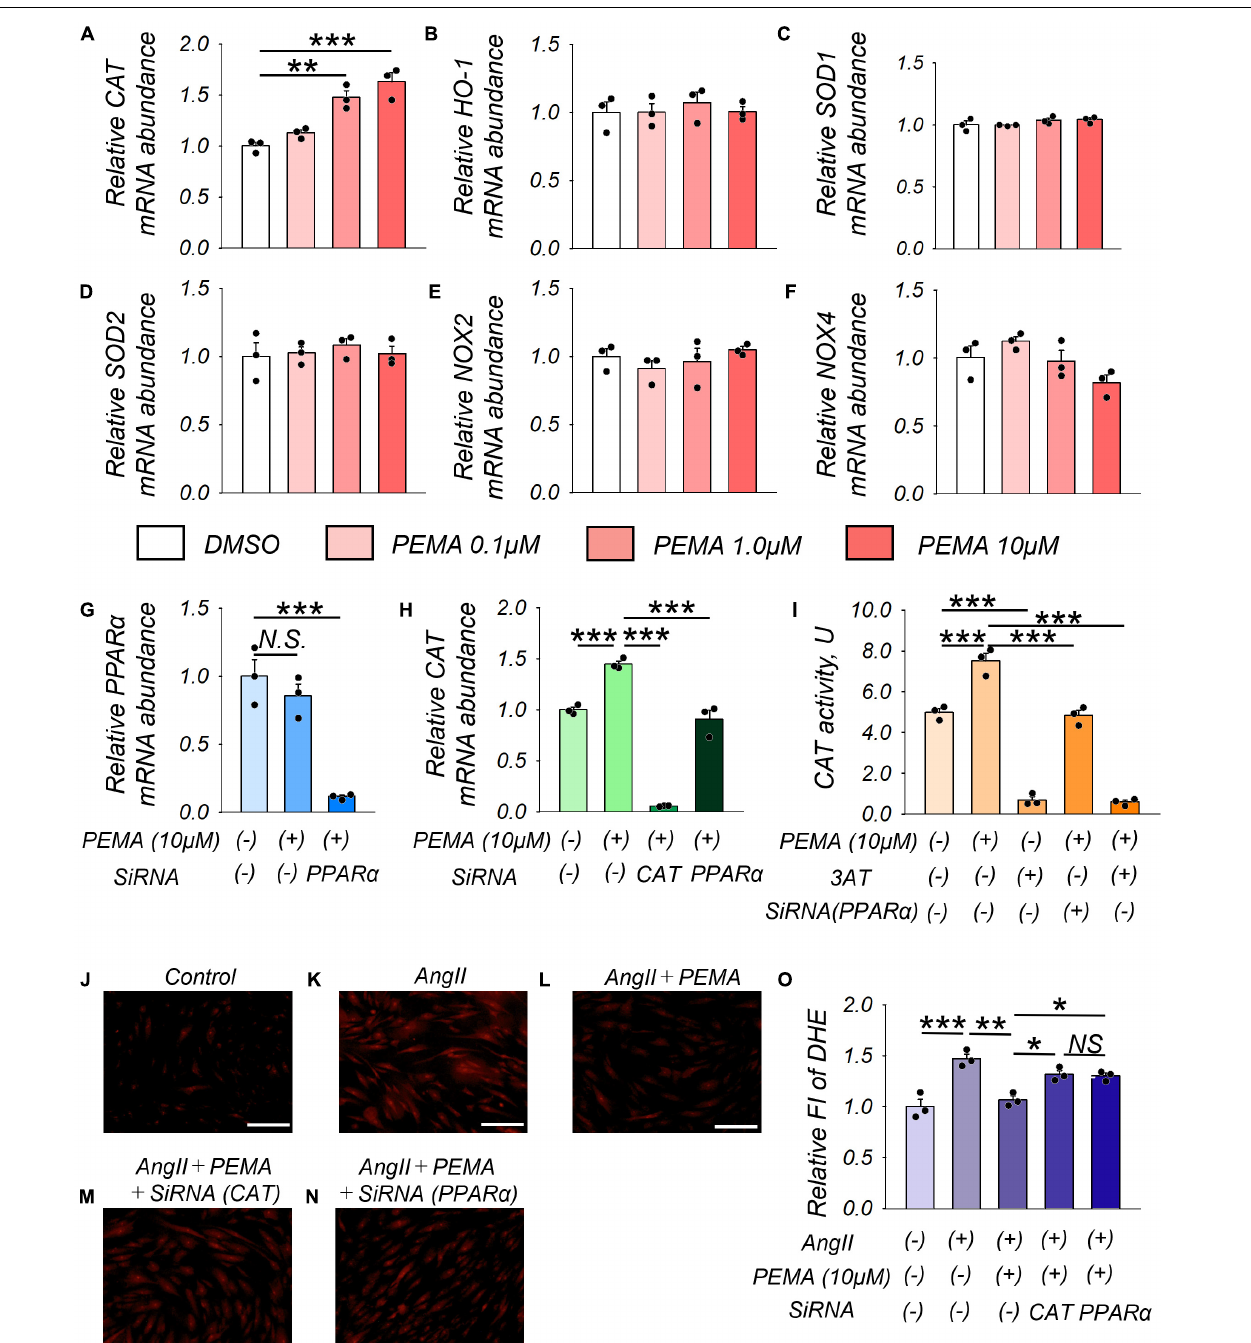
FIGURE 6 | Pemafibrate (PEMA)-mediated gene expression changes and the reduction in ROS in vascular smooth muscle cells (VSMCs). (A–F) mRNA expression levels of catalase ( CAT ), heme oxygenase-1 ( HO-1 ), superoxide dismutase 1 ( SOD-1 ), SOD-2 , nicotinamide adenine dinucleotide phosphate oxidases ( NOX2 and NOX4 ) in VSMCs treated with dimethyl sulfoxide (DMSO) and PEMA (0.1, 1.0, and 10 µ M) for 24 h. (G) mRNA expression levels of peroxisome proliferator-activated receptor alpha ( PPAR α ) in VSMCs treated with 10 µ M PEMA with or without transfection using SiRNA of PPAR α for 24 h before the PEMA administration. (H) mRNA expression levels of PPAR α in VSMCs treated with 10 µ M PEMA with or without transfection using SiRNA of CAT or PPAR α . All gene expression analyses were conducted using quantitative reverse transcription-polymerase chain reaction, and each gene expression level was normalized using glyceraldehyde 3-phosphate dehydrogenase ( GAPDH ). (I) CAT activity in VSMCs (1.0 × 10 7 cells) treated with 10 µ M PEMA in the presence or absence of 3-amino-1,2,4-triazole (3AT) treatment and/or transfection using SiRNA of PPAR α . Representative results of DHE staining (J–N) and relative DHE fluoro-intensity (FI) (O) of VSMCs stimulated with AngII (100 nM) with or without PEMA, and/or transfection using SiRNA of CAT or PPAR α . All analyses were performed using analysis of variance and Bonferroni corrections; n = 3 per group, performed in duplicates. Data are expressed as mean ± standard error of the mean. * p < 0.05; ** p < 0.01; *** p < 0.001. N.S., not significant.